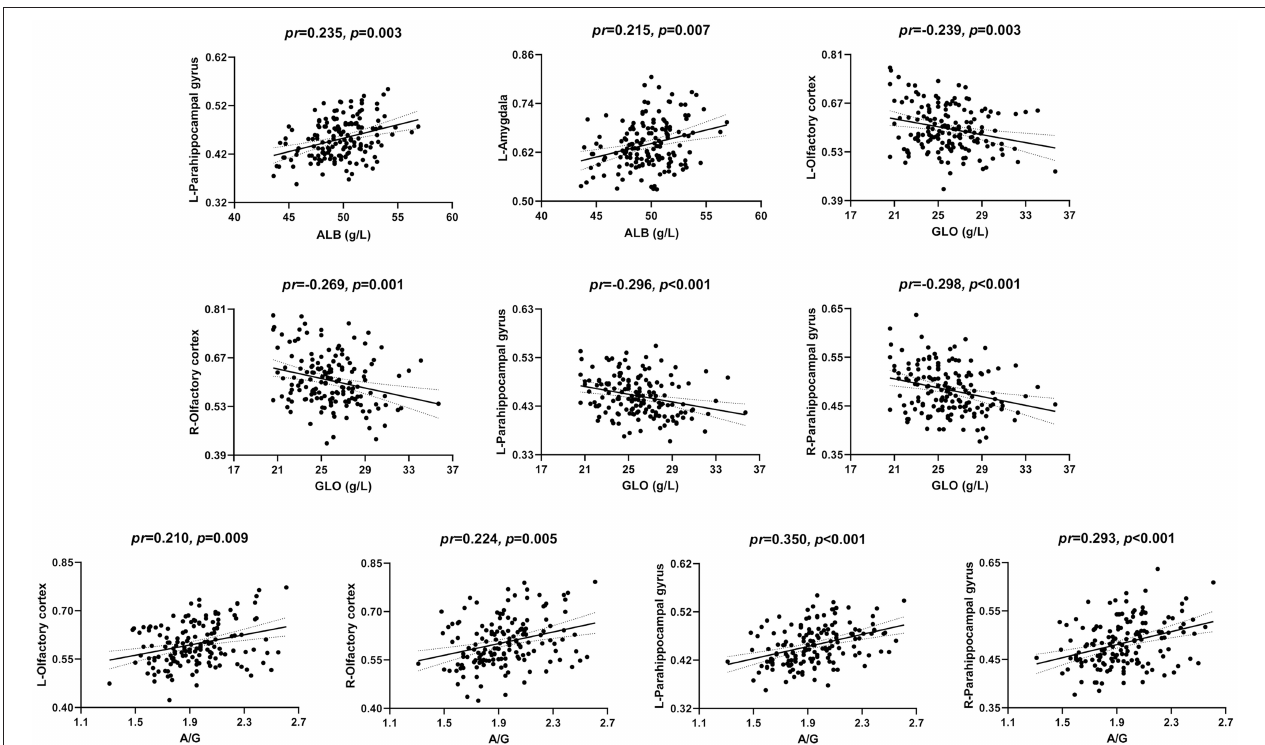
FIGURE 1 | Scatter plots of the correlations between serum proteins and GMV. Abbreviations: GMV, gray matter volume; ALB, albumin; GLO, globulin; A/G, albumin/globulin; pr , partial correlation coefficient; L, left; R, right.